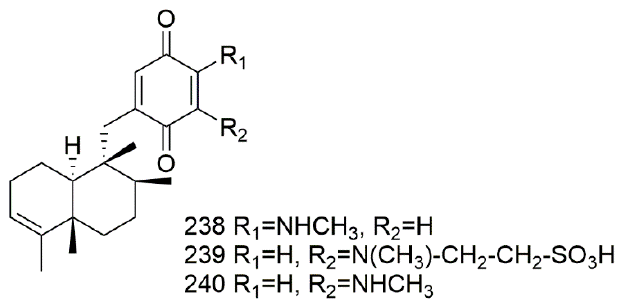
Figure 20. Sesquiterpene quinones/hydroquinones alkaloid structures isolated from sponges. Table 20. Cytotoxic activity of sesquiterpene quinones/hydroquinones alkaloids. Place of Compound Source Ref. Cell Line Collection